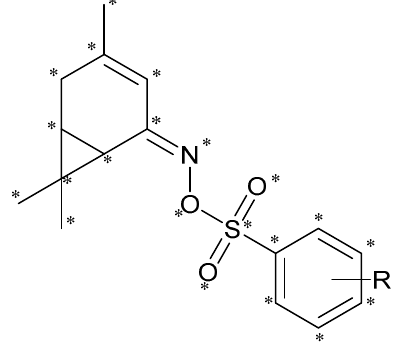
Figure 4. The asterisk skeleton of title compounds.